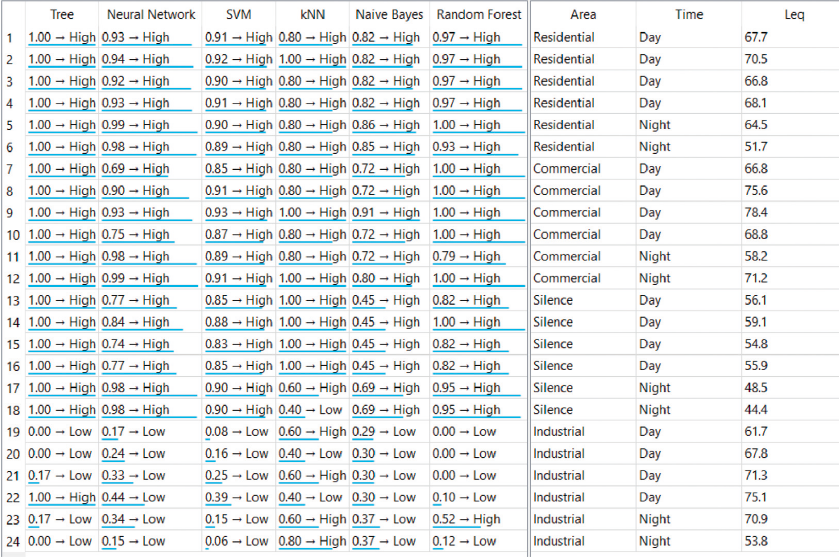
Figure 15: Prediction of high noise level using different ML models for the input instances with probability values (0.001–1.00).